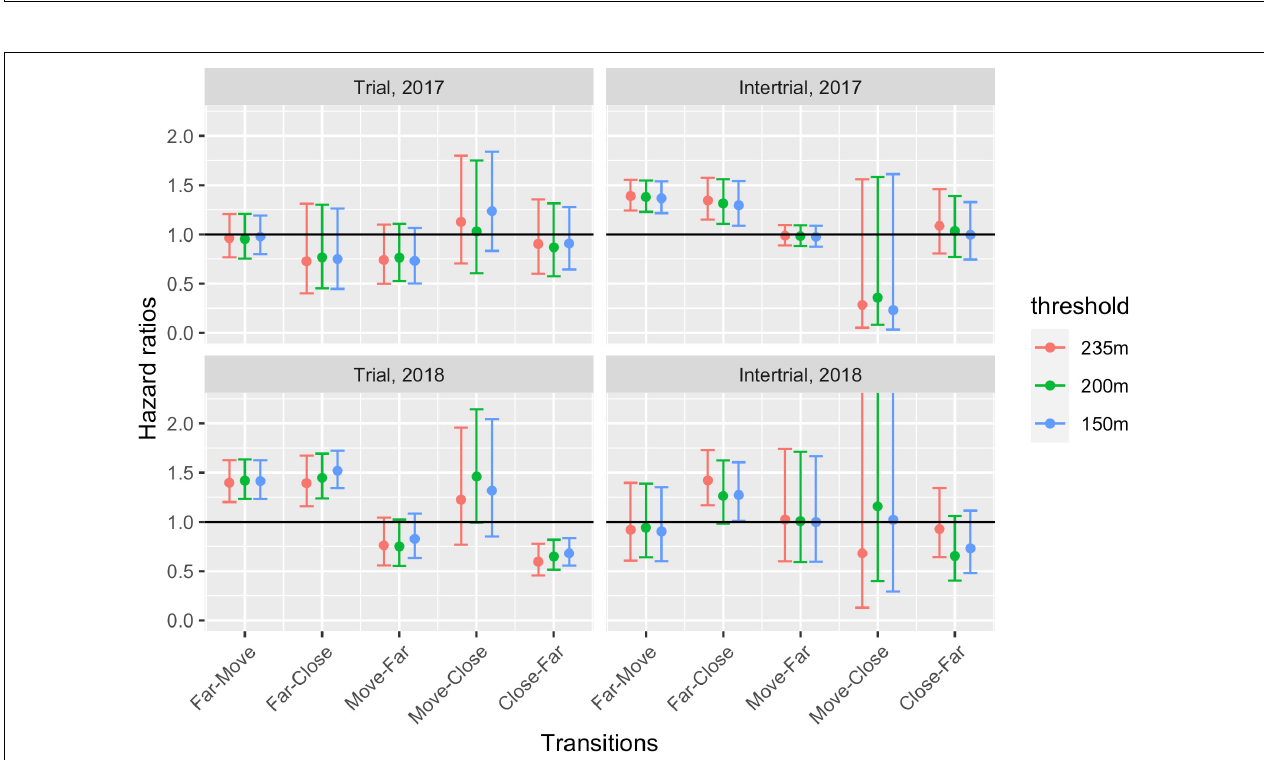
FIGURE 10 | Estimated hazard ratios for an increase of 0.1 km − 1 in the exposure together with 95% confidence intervals for different threshold (150, 250, and 235 m from shore) under trials (seismic activity) and intertrials (presence of ship). The black horizontal lines at 1 indicates no effect of exposure.